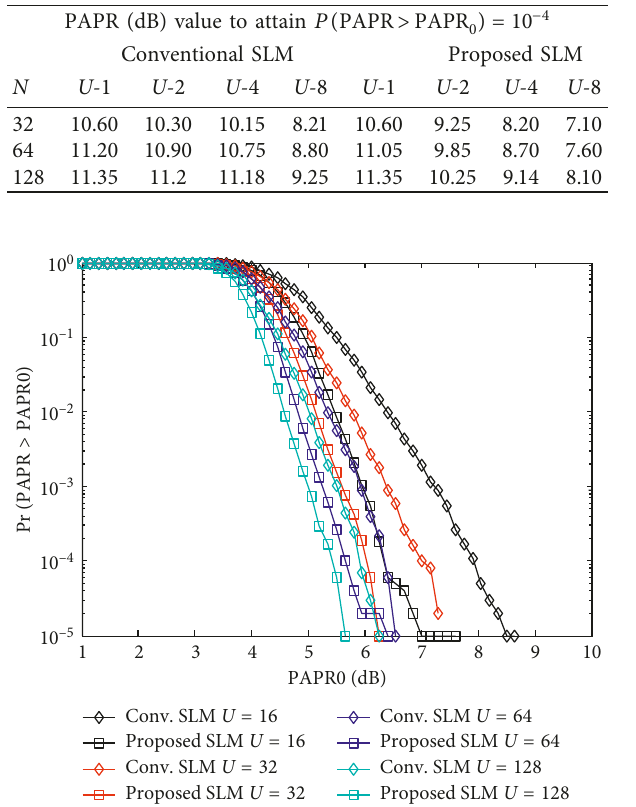
Figure 6: Comparison of SLM given in [5] with the proposed SLM for U � 16, 32, 64, and 128, N � 32, and 4-PSK.